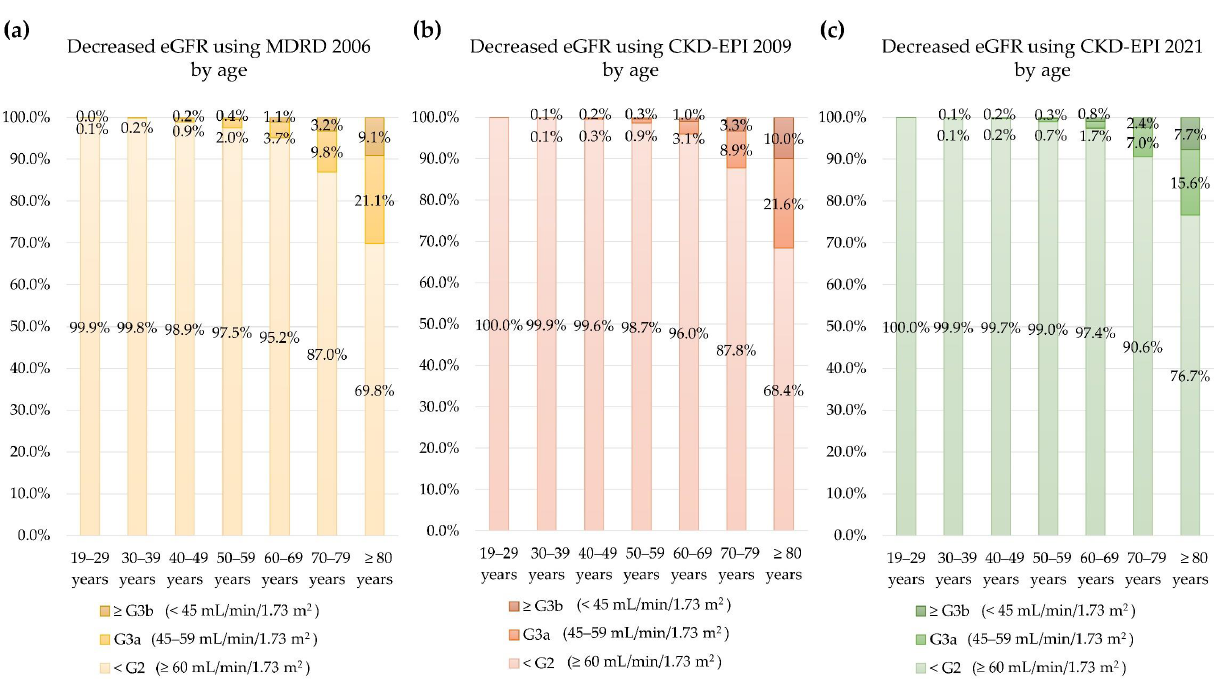
Figure 2. Prevalence of decreased eGFR (< 60 mL/min/1.73 m 2 ) by age using ( a ) MDRD 2006, ( b ) CKD-EPI 2009, and ( c ) CKD-EPI 2021.